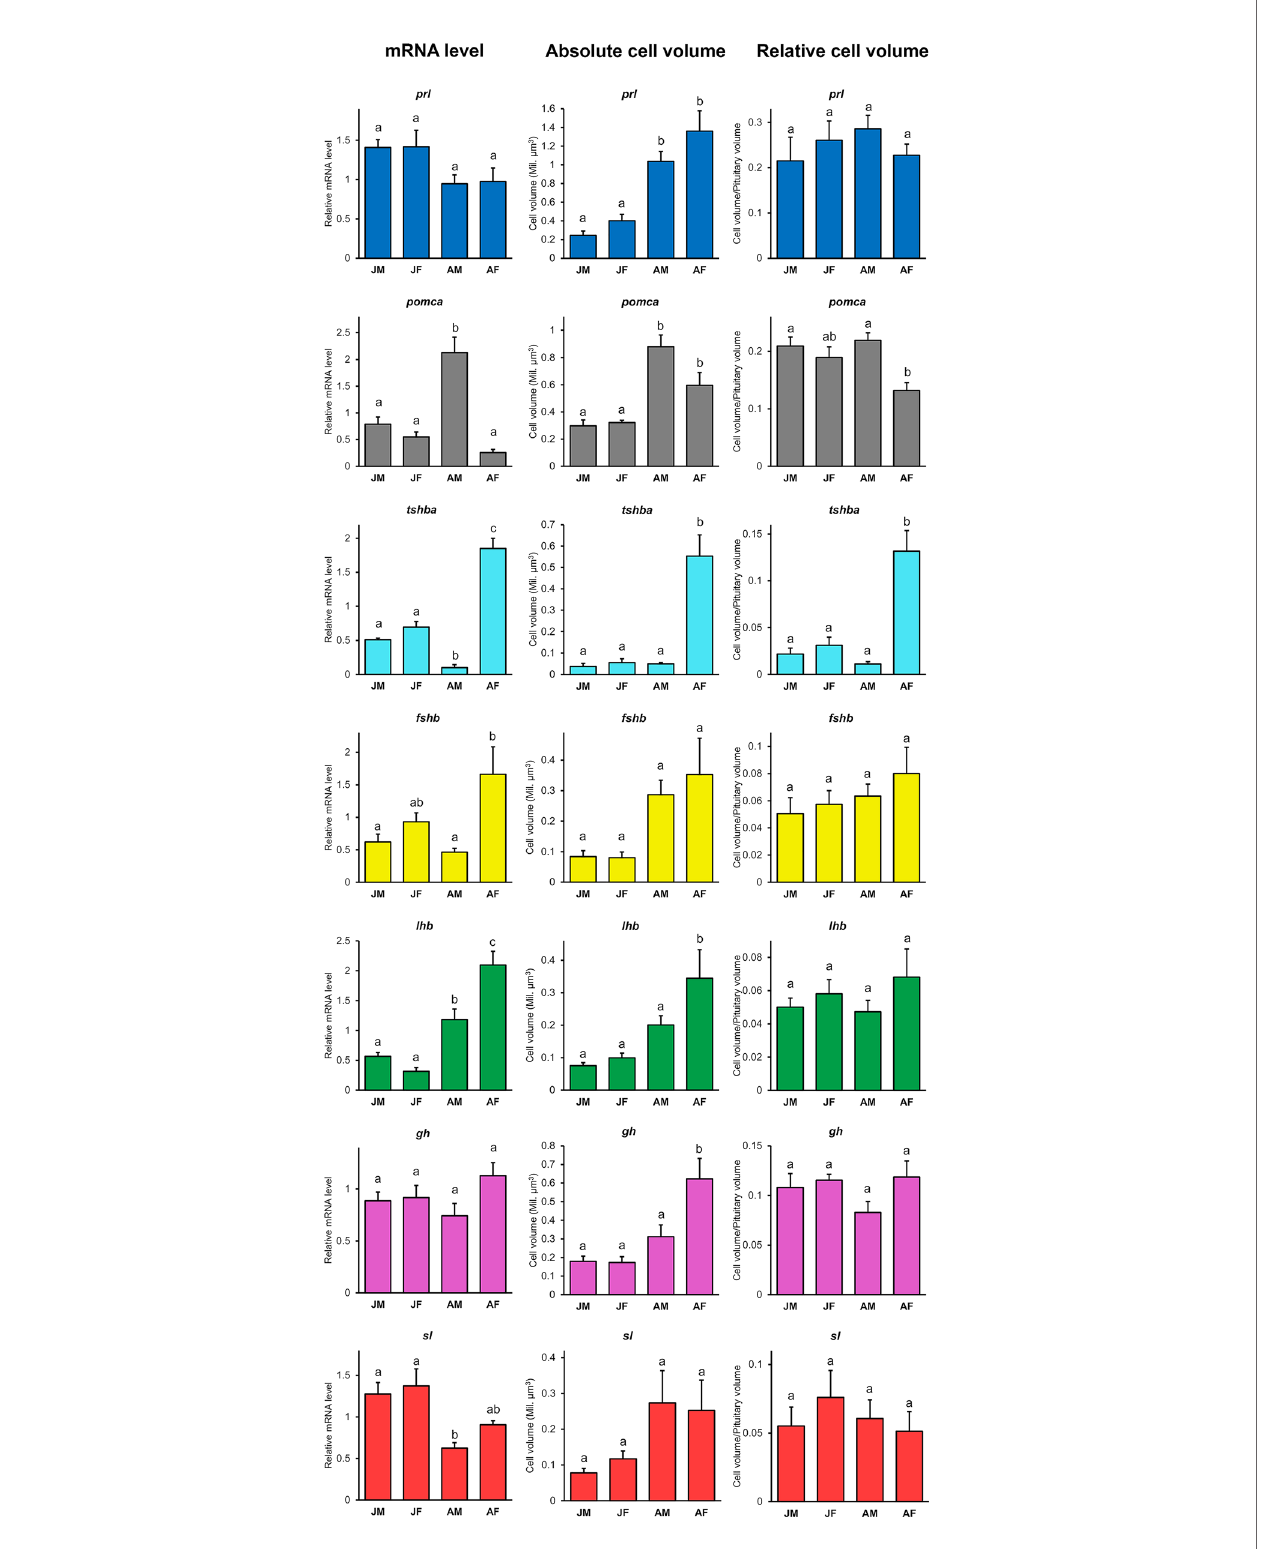
FIGURE 4 | Relative mRNA levels for seven hormone-encoding genes ( prl , pomca, tshba , fshb , lhb , gh , and sl ), absolute cell population volumes and relative cell volumes in juvenile and adult medaka males and females (juvenile male, JM; juvenile female, JF; adult male, AM; adult female, AF). Graphs are provided as mean + SEM (n = 4 - 8). Different letters display statistical differences ( p < 0.05) between groups as evaluated by One-way ANOVA followed by Tukey post hoc